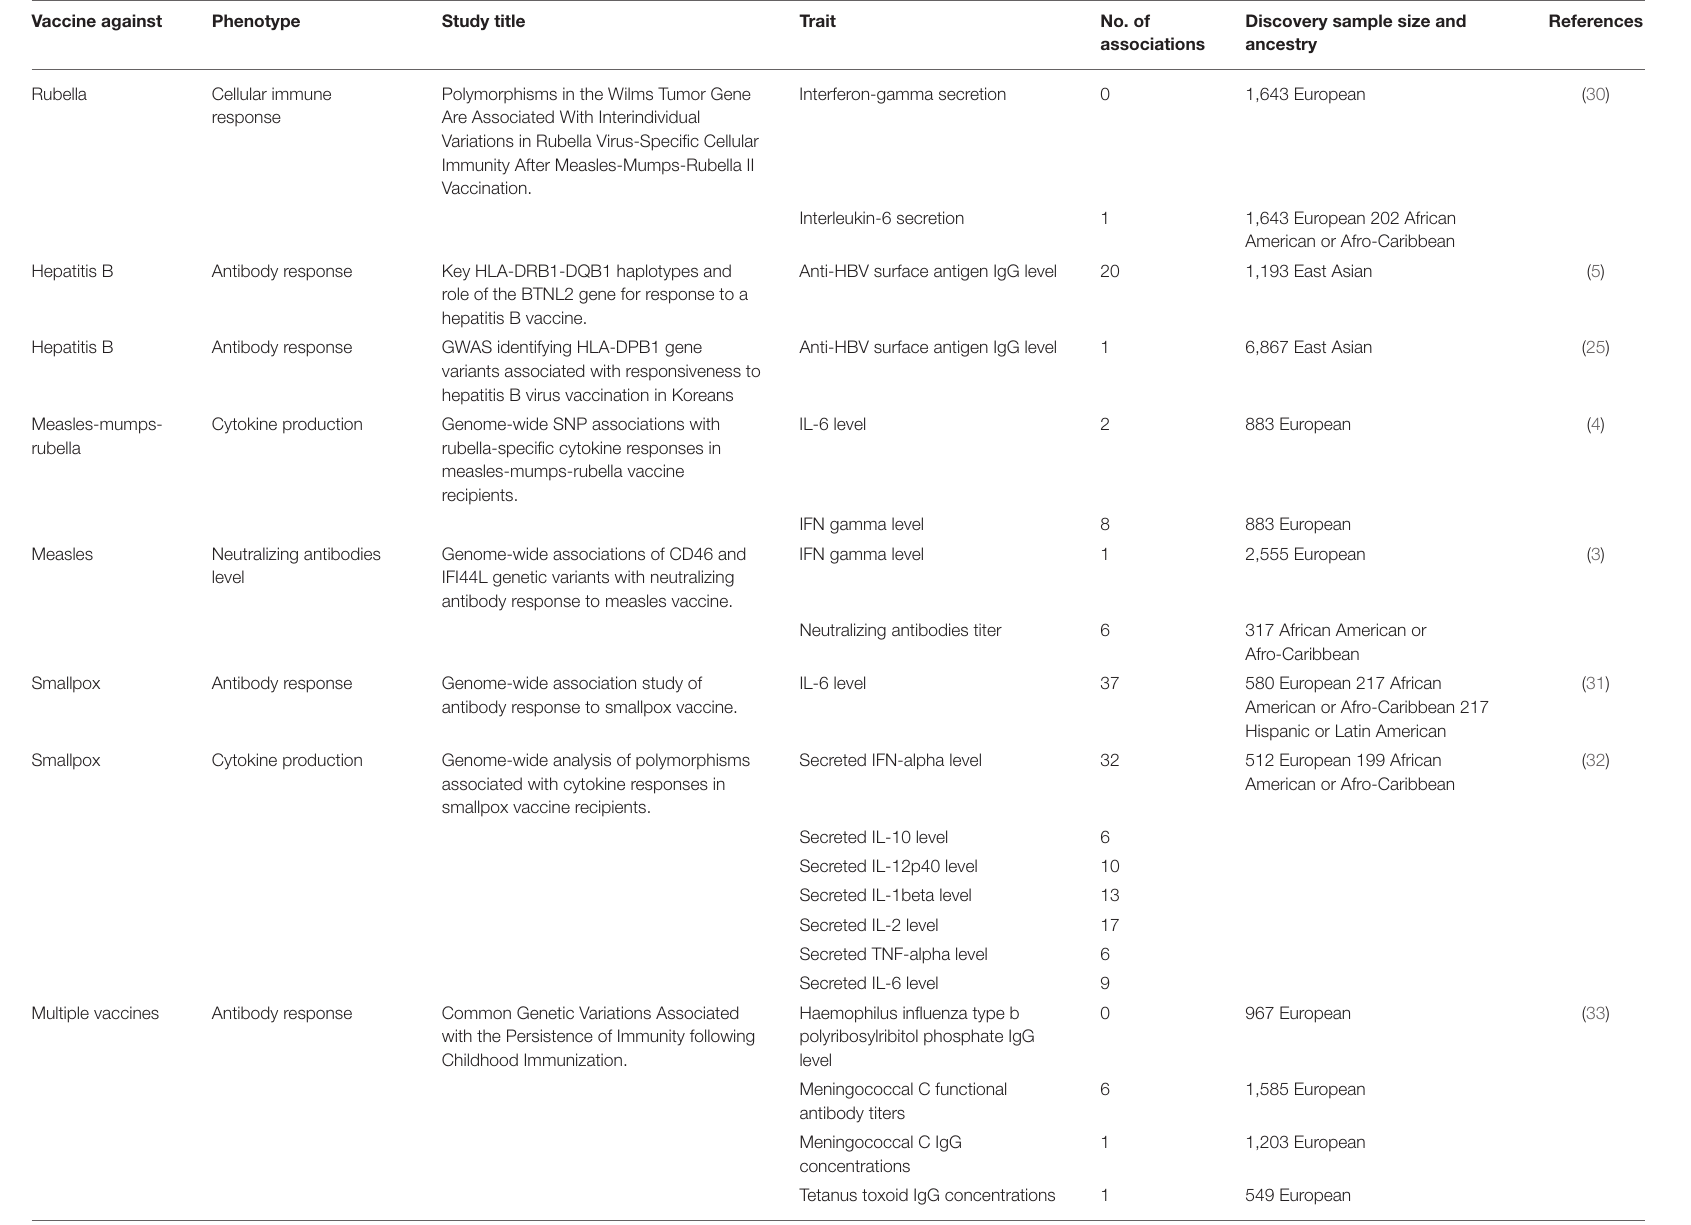
TABLE 1 | List of all GWA studies on vaccine response retrieved from the GWAS catalog as of June